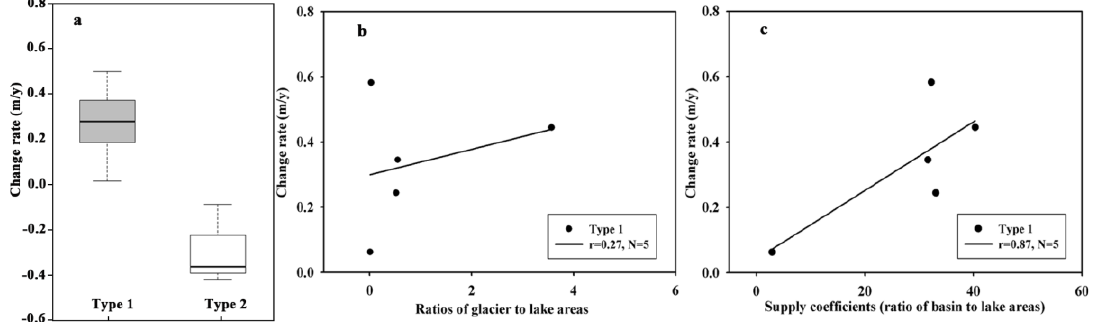
Figure 5. ( a ) Water level change rate of alpine lakes (type 1) and non-alpine lakes (type 2); ( b ) anal- ysis of relationship between water level change rate and G – L ratio in type 1 lakes; ( c ) analysis of relationship between water level change rate and supply coefficient in type 1 lakes.